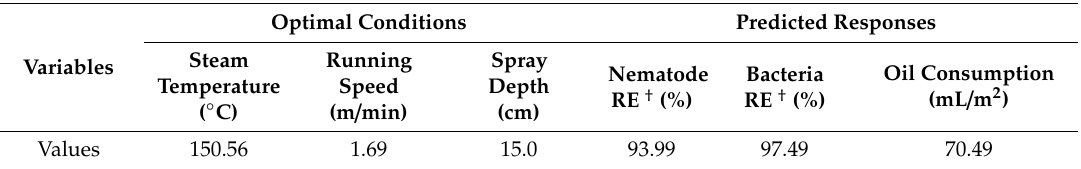
Table 4. Optimal operation parameters for the three explanatory variables.